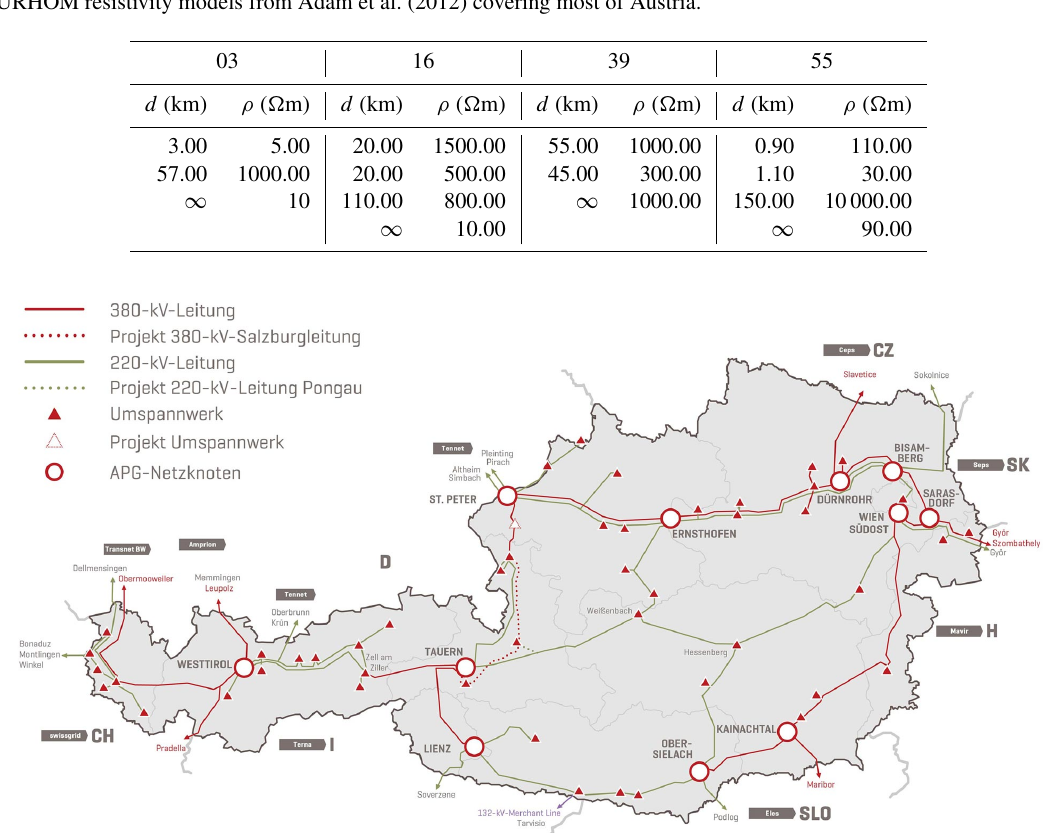
Figure 3. Depiction of the Austrian power grid provided by the APG. Triangles represent substations while circles represent network nodes. Red and grey lines are 380 and 220kV lines,